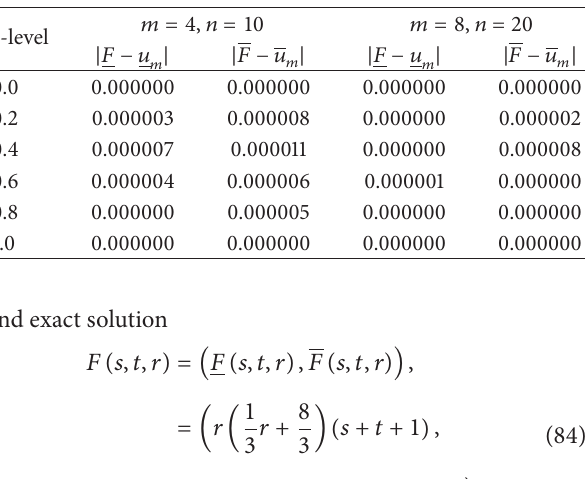
Table 2: Numerical results on the level sets for Example 2 in , 𝑡 ) = (0.5, 0.5) . (𝑠 0 0